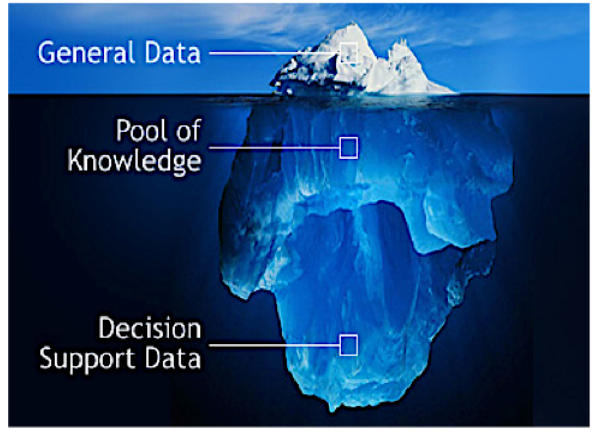
Figure 1. The scheme of CHICBERG